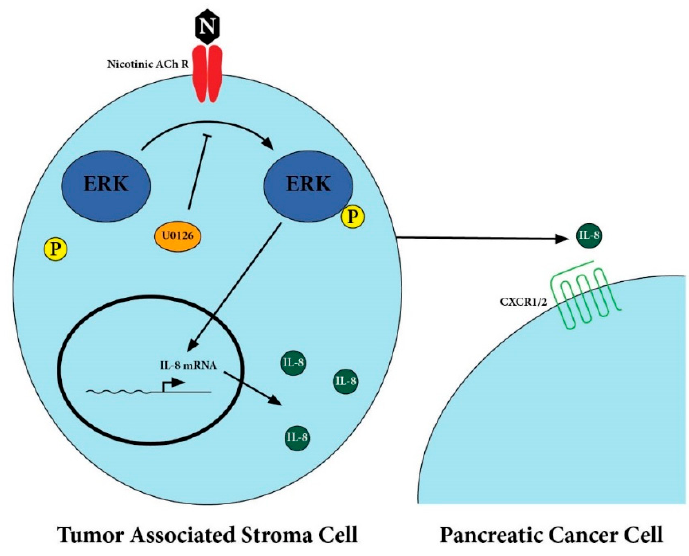
Figure 5. Proposed pathway for IL-8 secretion by tumor-associated stromal cells.